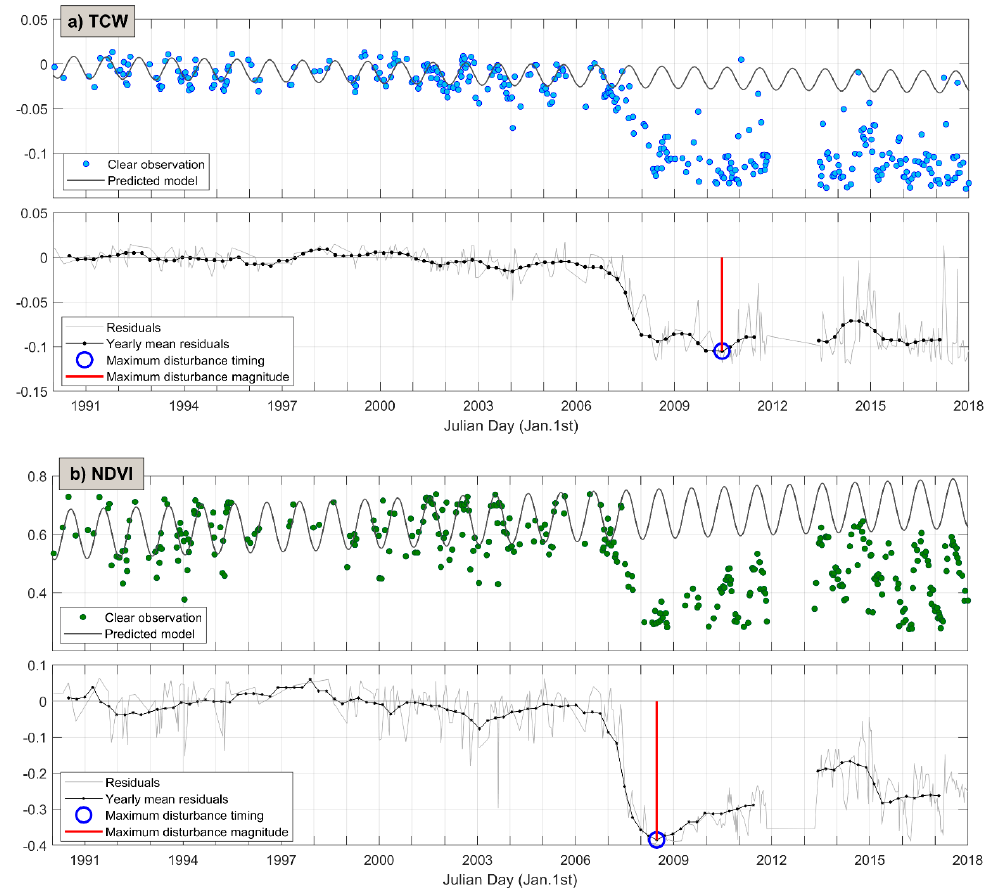
Figure 4. The spectral trajectories of ( a ) wetness (TCW) and ( b ) Normalized Difference Vegetation Index (NDVI), their residuals (light grey lines), and the mean values within 1-year moving windows with 3-month steps (solid black line with dots in lower panels) at a Landsat pixel with a fire in 2007. The residuals were the difference between the observed and projected values (dark grey line) fitted by Equation (1) before 2000. The maximum disturbance magnitude (red lines) and its timing (blue circles) are shown in the mean residuals’ trajectories.